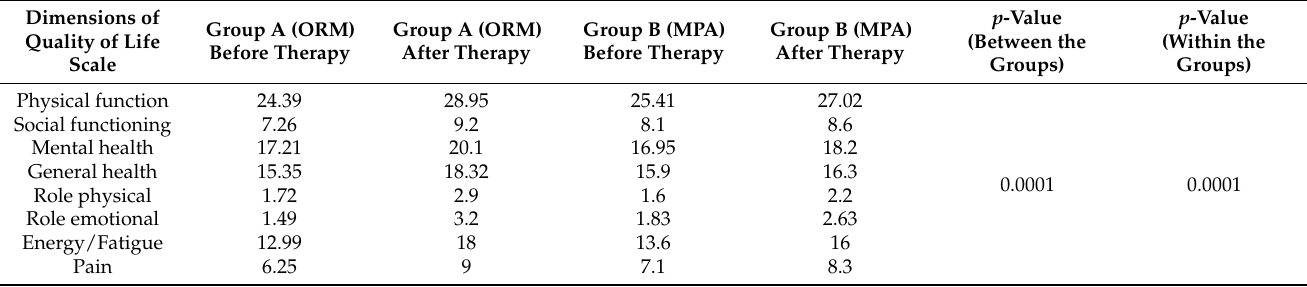
Table 4. Comparative findings about SF-36 quality of life scale after ORM and MPA therapy.